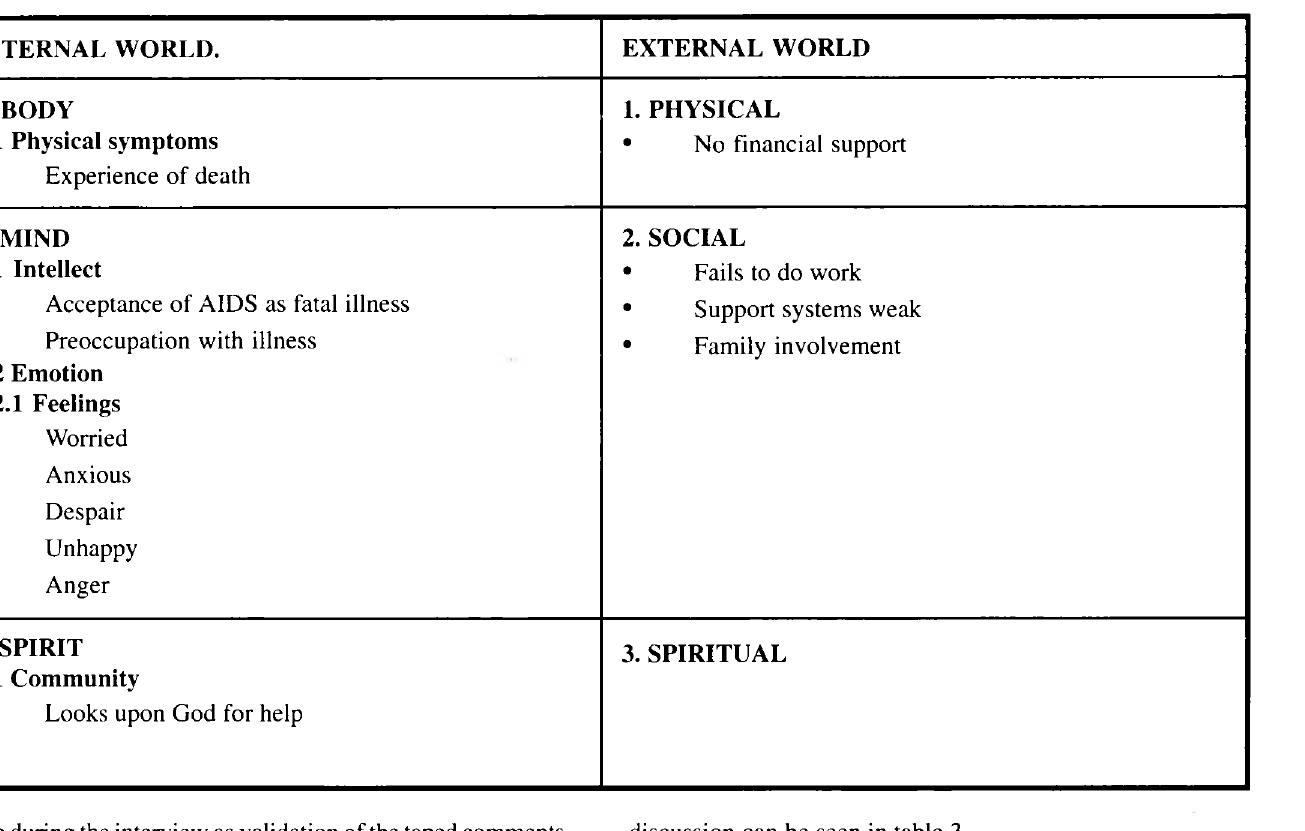
Most important themes generated by